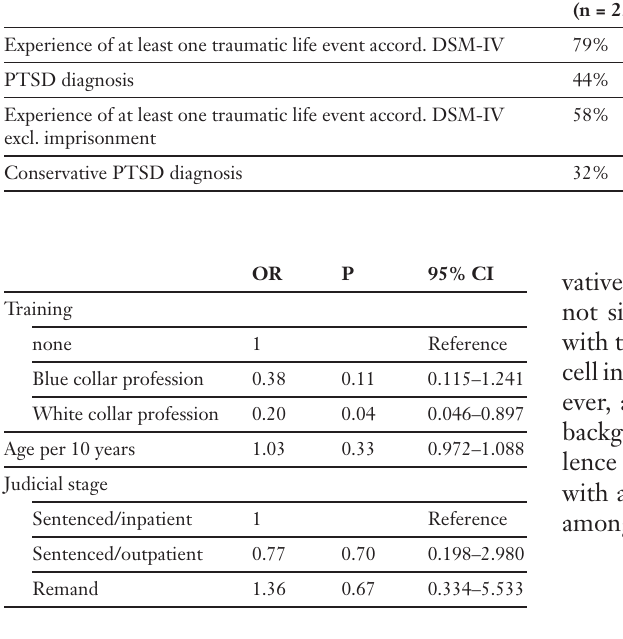
Traumatic life events and prevalence of PTSD diagnosis.